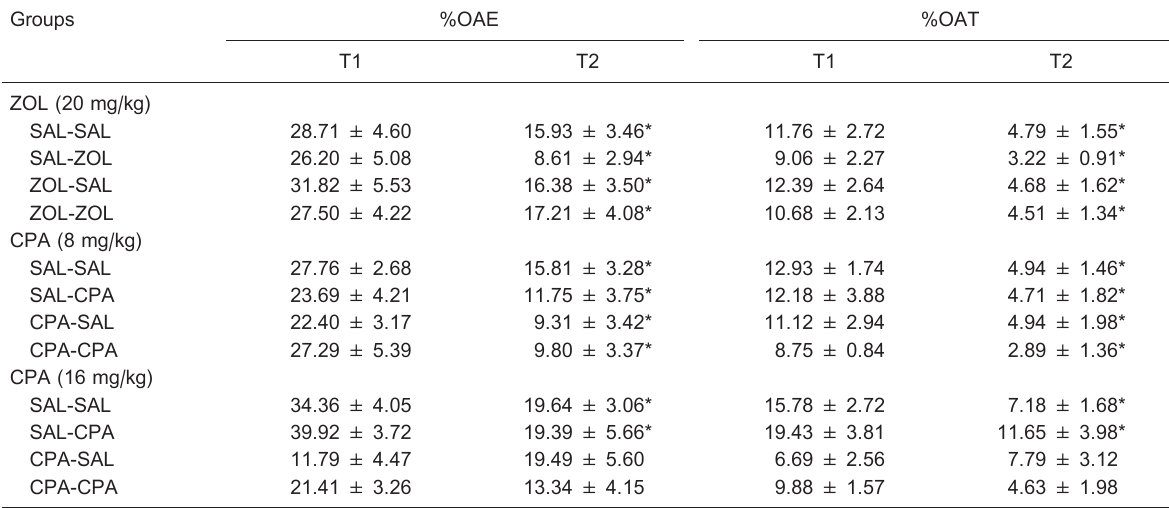
Table 3. Effects of ip injection of zolantidine (ZOL) or 8 or 16 mg/kg chlorpheniramine (CPA) prior to Trial 1 (T1) and Trial 2 (groups formed from subdivision in T2) on the behavioral measures in mice re-exposed to elevated plus-maze testing.